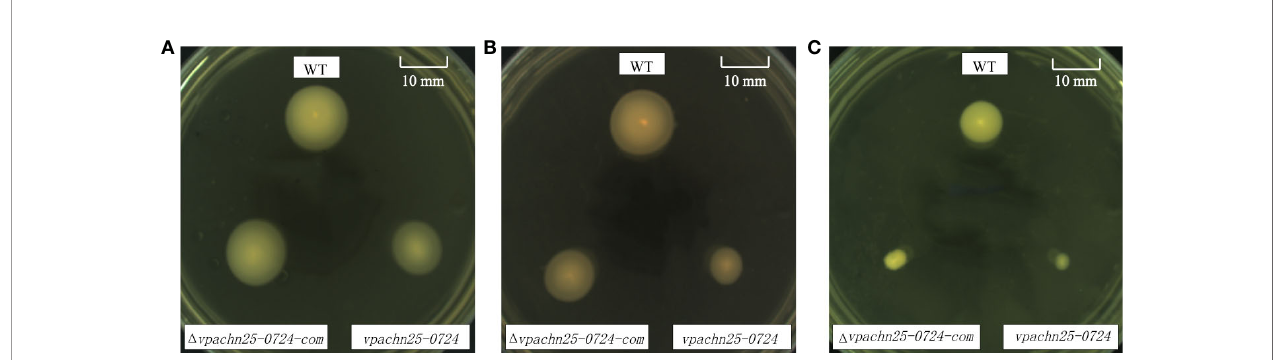
FIGURE 3 | Swimming motility of V. parahaemolyticus CHN25 (WT), D VpaChn25_0724 , and D VpaChn25_0724 -com strains at different temperature. A: 37°C; B: 25°C; C: 15°C; WT: wild type. The strains were incubated on the semi-solid TSB agar plates containing 0.25% agar at 37°C (A) , 25°C (B) , 15°C (C) , respectively. WT,